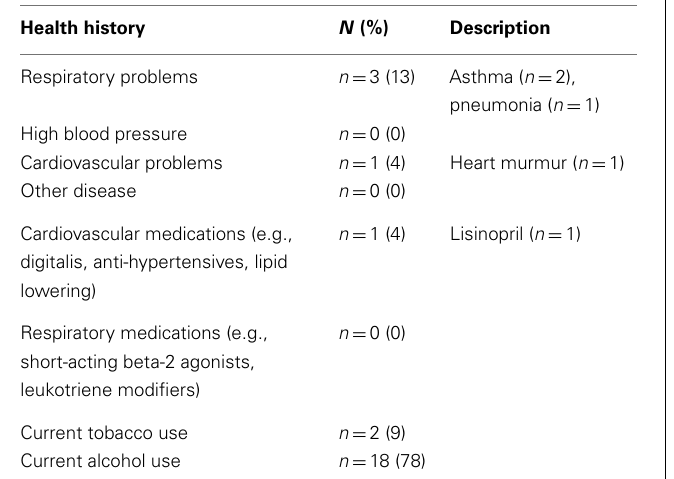
Table 2 | Participant health history ( N = 23).